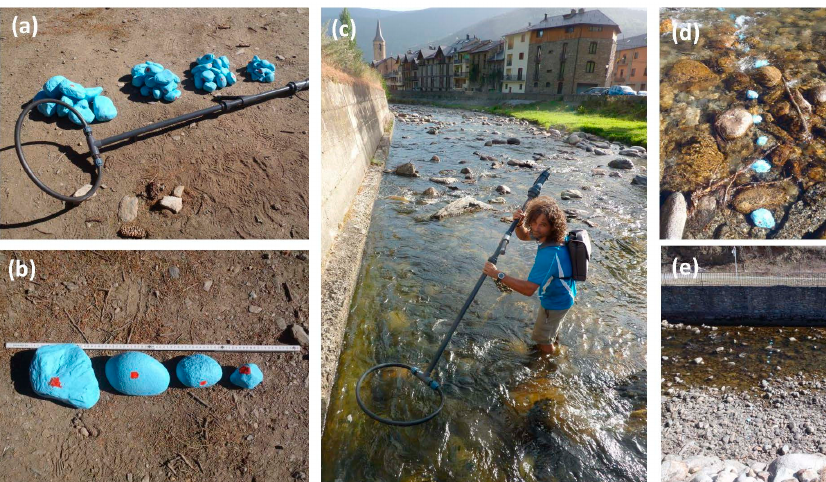
Figure 5. Examples of RFID tracers deployed in the study reaches. This technique was used in reaches R1 (reference) and R2 (immediately downstream the hydropower station). ( a , b ) Tracers and equipment used. ( c ) Recovering tracers after mobility. ( d , e ) Tracers seeded in the river-bed of sections R2 and R1 respectively.